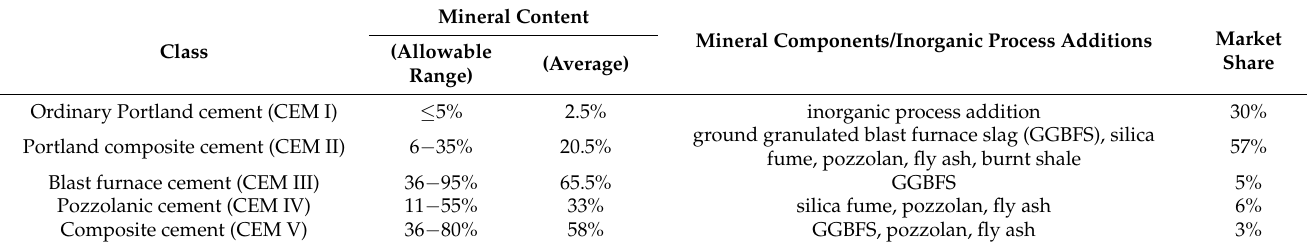
Table 1. Cement regulations following European Standard (EN 197-1)